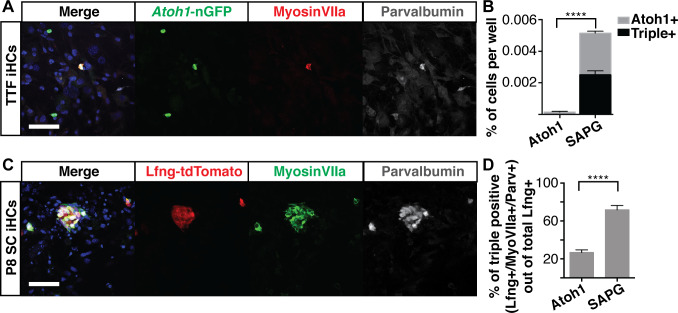
Six1, Atoh1, Pou4f3 and Gfi1 are capable of reprogramming adult cells.(A) Adult mouse tail tip fibroblasts (TTFs) were infected with SAPG and allowed to reprogram for 14 days before fixation and immunostaining. Reprogrammed TTF are able to activate the Atoh1-nGFP reporter and stain for anti-MyosinVIIa (red) and anti-Parvalbumin (grey). Merged image includes Hoechst nuclear stain (blue). TTFs were reprogrammed in HCM supplemented with 10% FBS and RepSox. Scale bar represents 50 um. (B) Quantification of Atoh1-nGFP+ cells and triple positive cells (Atoh1-nGFP+/MyosinVIIa+/Parvalbumin+) in TTFs infected with Atoh1 alone or SAPG. TTFs infected with SAPG generate significantly more Atoh1-nGFP+ cells and 48.6% (± 12) of the Atoh1-nGFP+ cells are triple positive. TTFs were reprogrammed in HCM supplemented with 10% FBS and RepSox. (N = 3 experiments, n = 3 replicates per experiment, mean ± SEM; Statistics shown for the comparison of triple positive cells in each condition; Student’s t-test *p<0.05, **p<0.01, ***p<0.001, ****p<0.0001). (C) Dissociated organs of Corti from P8 transgenic mice with lineage traced supporting cells (Lfng-tdTomato+ SC) were infected with SAPG. Cells were reprogrammed for 14 days prior to fixation and immunostaining for anti-MyosinVIIa (green) and anti-Parvalbumin (grey). P8 Lfng-tdTomato+ SCs infected with SAPG are able to activate primary hair cell markers MyosinVIIa and Parvalbumin. Scale bar represents 50 um. (D) Quantification of the percent of triple positive cells (Lfng-tdTomato+/MyosinVIIa+/Parvalbumin+) out of the total number of Lfng-tdTomato+ supporting cells per well in cultures infected with Atoh1 alone or SAPG. Presence of the Lfng-tdTomato reporter is independent of the viral infection. With Atoh1 alone 26.8% (± 7) of the total Lfng-tdTomato+ supporting cells are able to activate the primary hair cell markers MyosinVIIa and Parvalbumin, while with SAPG 71.8% (± 12) of the total Lfng-tdTomato+ supporting cells are able to activate primary hair cell markers. (n = 7 replicates, mean ± SEM; Student’s t-test *p<0.05, **p<0.01, ***p<0.001, ****p<0.0001).